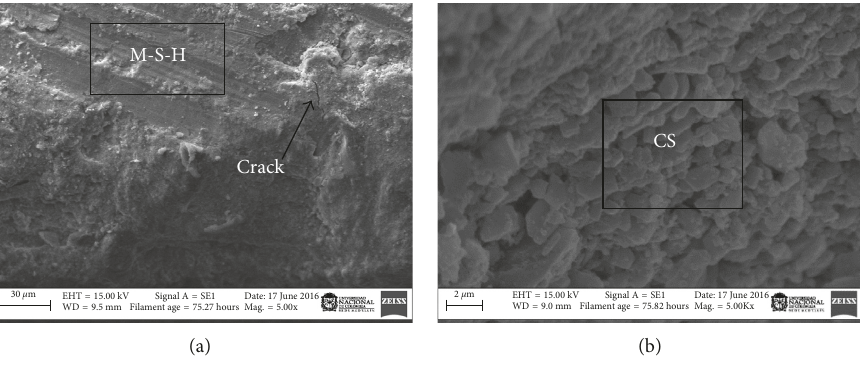
4 : (a) ALC5S-0 and (b) AlC5S-10.